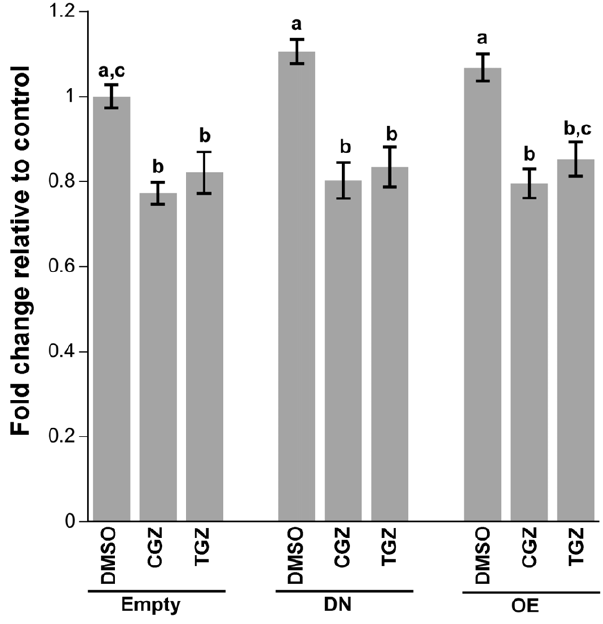
Figure 10. Effect of CGZ and TGZ treatment on Ovcar3 cell proliferation in cells transfected with DN or OE PPAR c constructs. Ovcar3 cells were double transfected, serum starved for 24 hours and treated for an additional 24 hours with vehicle control (DMSO) or10 m M of CGZ or TGZ. Cell proliferation was assessed with a BrdU assay. Results are the means 6 SEM for at least 9 measurements from three individual experiments. Bars that do not share a letter designation are significantly different within a treatment group ( p , 0.05).